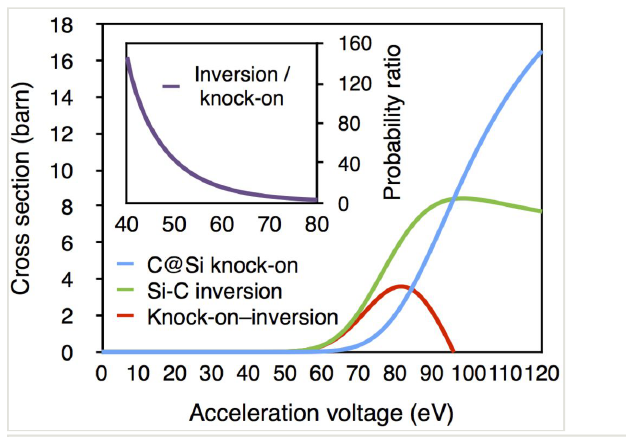
Figure 3. Interaction cross sections for relevant electron-beam induced processes at silicon dopant sites based on DFT calculations conducted previously by the principal investigator (Susi et al.